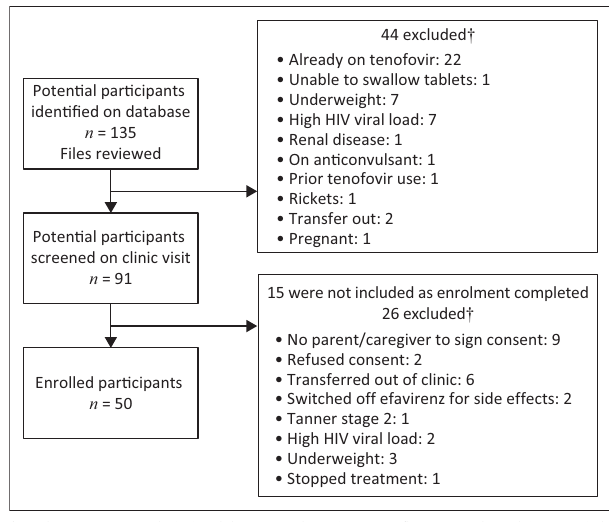
FIGURE 1: Study flow-chart of inclusion and exclusions of adolescents assessed for switch to TDF-containing